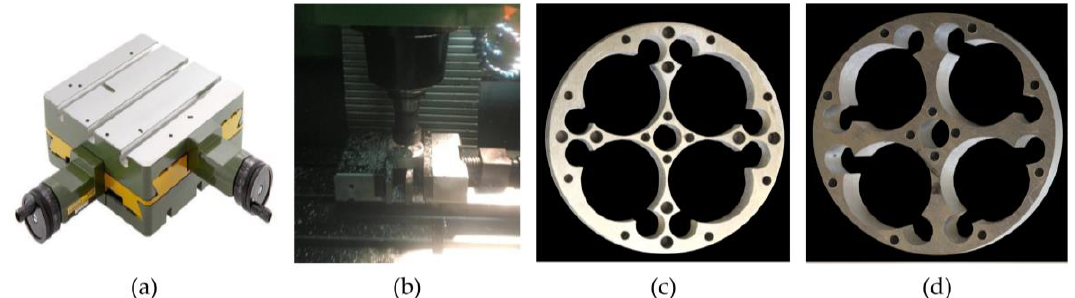
Figure 13. Improvements in manufacturing ( a ) Manual control bench; ( b ) Computerized numerical control (CNC) milling machine; ( c ) Sensor 1 Nm; ( d ) Sensor 20